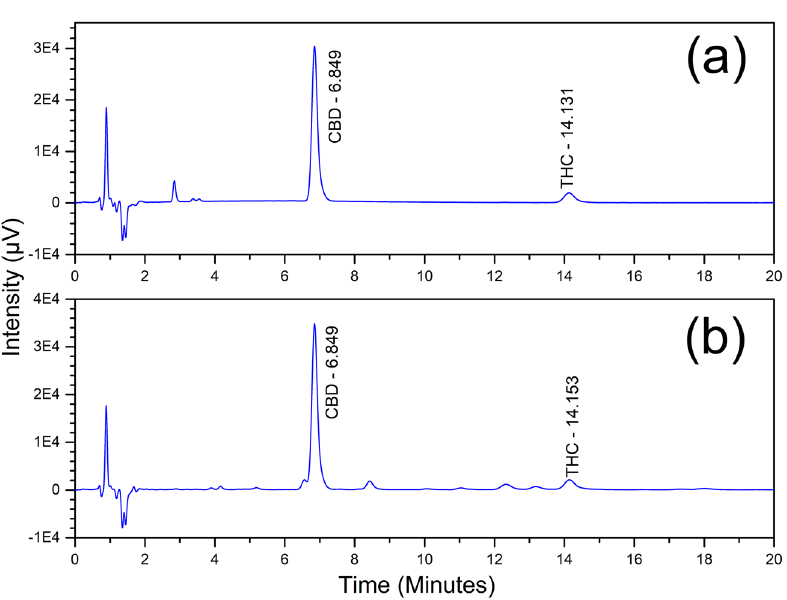
Figure 6. ( a ) Standard and ( b ) sample chromatograms from precision testing for CBD and THC assay method